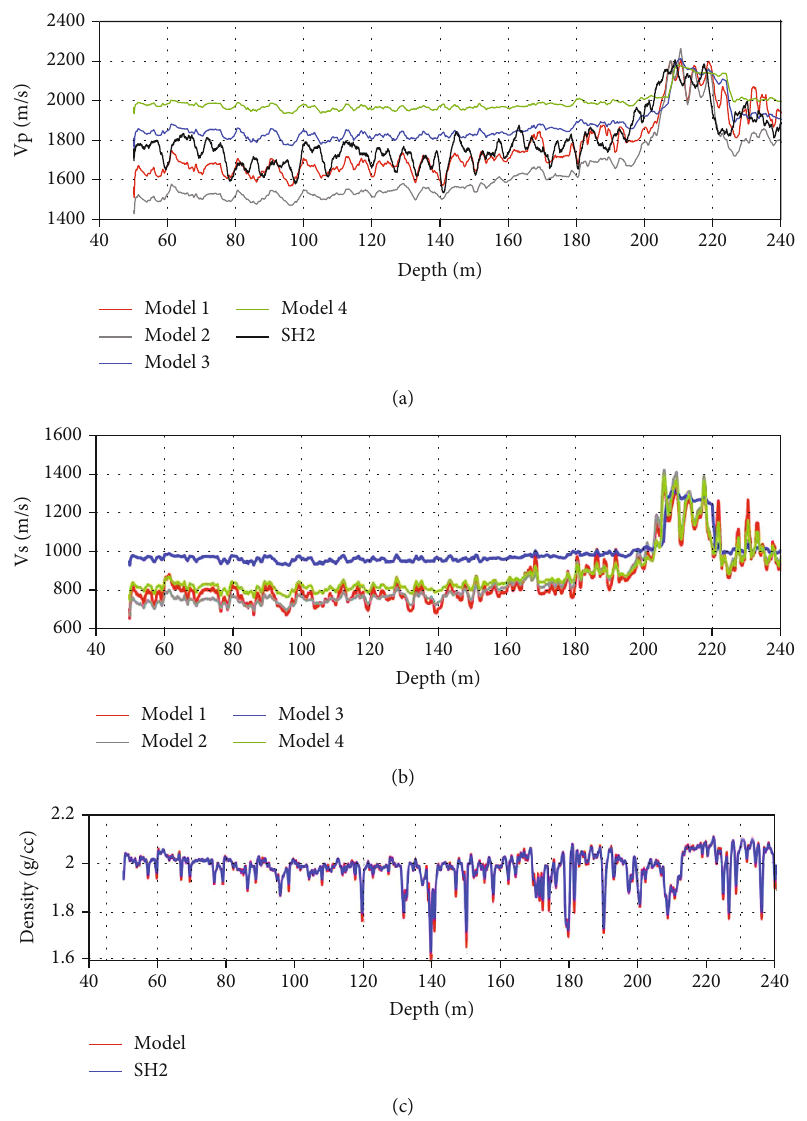
of di ff erent models, (b) V of p s